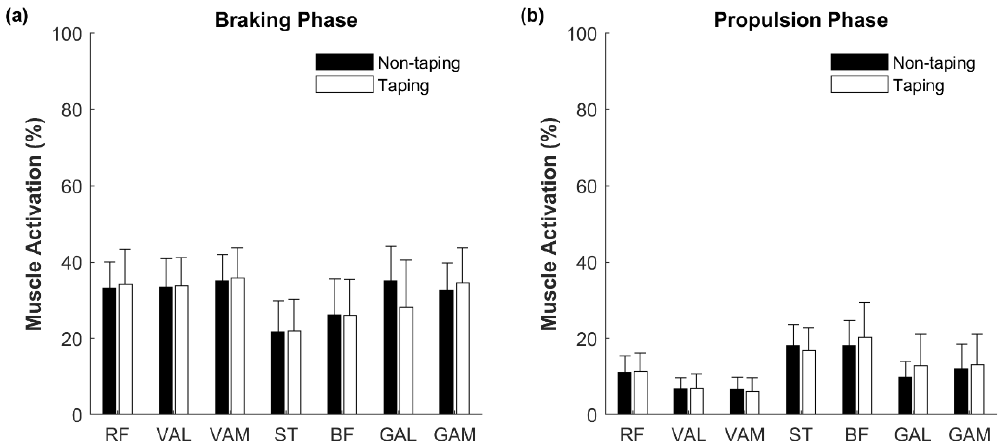
Figure 4. Muscle activation during side hops. ( a ) The electromyography (EMG) activity level of the examined muscles in the braking phase. ( b ) The EMG activity level of the examined muscles in propulsion phases. RF: rectus femoris; VAL: vastus lateralis; VAM: vastus medialis; ST: semitendinosus; BF: biceps femoris; GAL: lateral gastrocnemius; GAM: medial gastrocnemius.